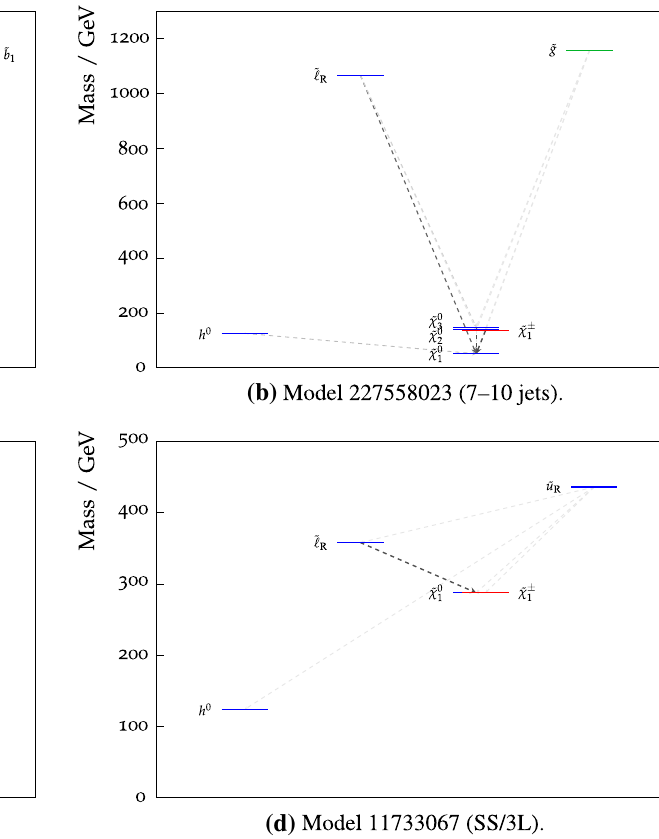
gluino with an LSP mass below 100 GeV, while for the SS/3L search, we selected the model with the lightest squark. For the Multi-b analy- sis, displayed is a model selected from the region in Fig. 1 where the density of red points is greatest. The model for the 1-lepton search is chosen based on one that is representative from the mass distributions in Fig.